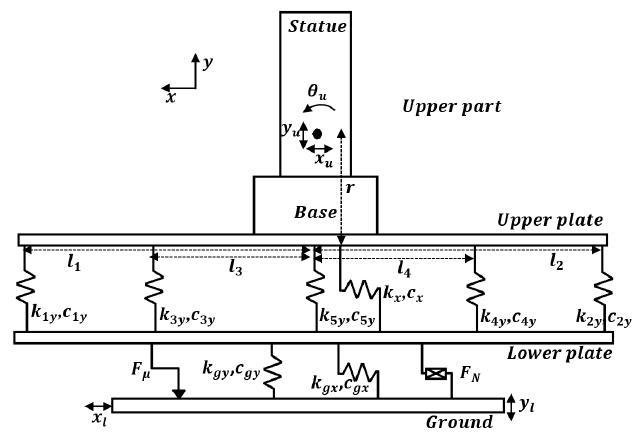
Figure 5. The five degrees of freedom (5DOF) model of the isolator with nonlinear dissipating force and friction.